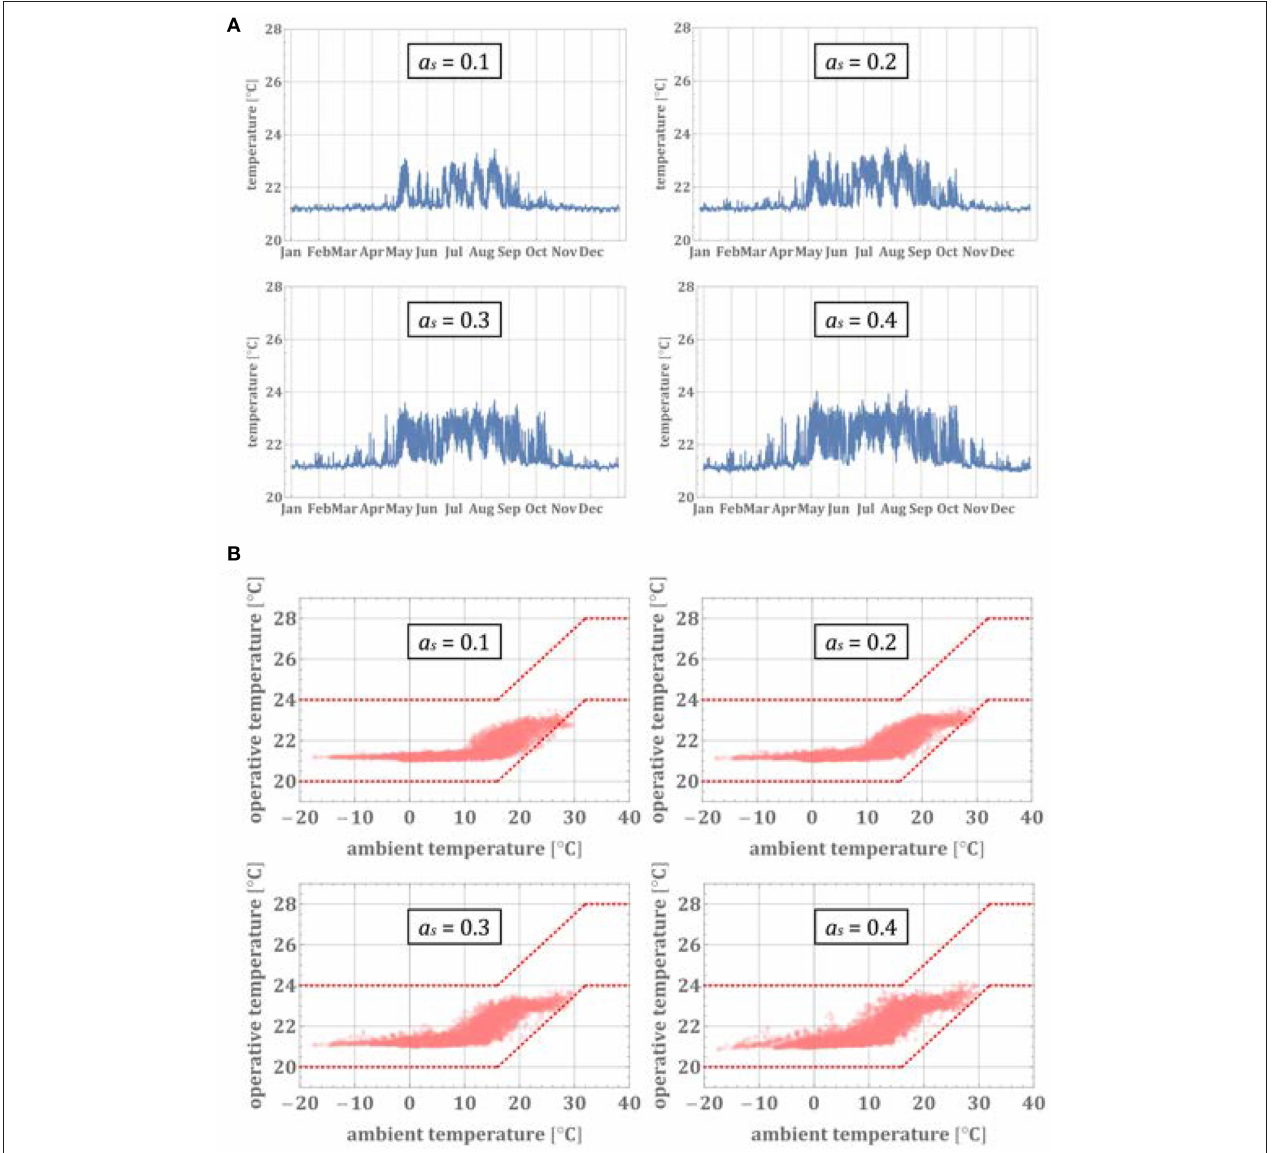
FIGURE 12 | (A) Indoor temperature of a lowly-occupied office room for different window-to-floor area ratios and implementing fluidic IGUs. (B) Thermal comfort evaluation according to DIN EN 15251 (DIN, 2012) for a lowly-occupied office room and variable window-to-floor area ratios, implementing fluidic IGUs (see text for